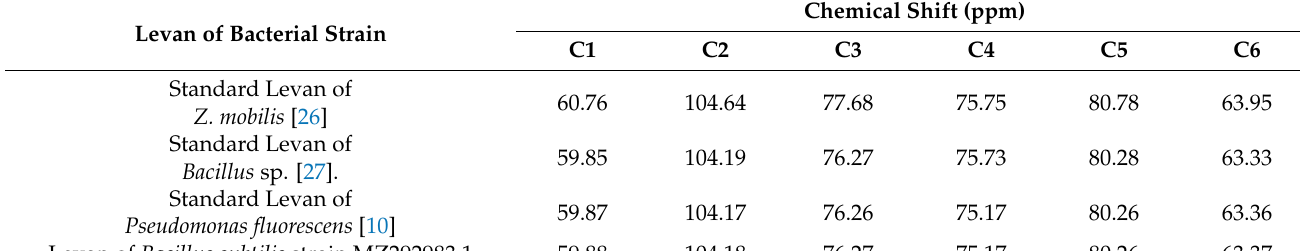
Table 1. Comparison between 13 C NMR chemical shift between the characterized levan from Bacillus subtilis strain MZ292983.1 and the previously reported and extracted levan.